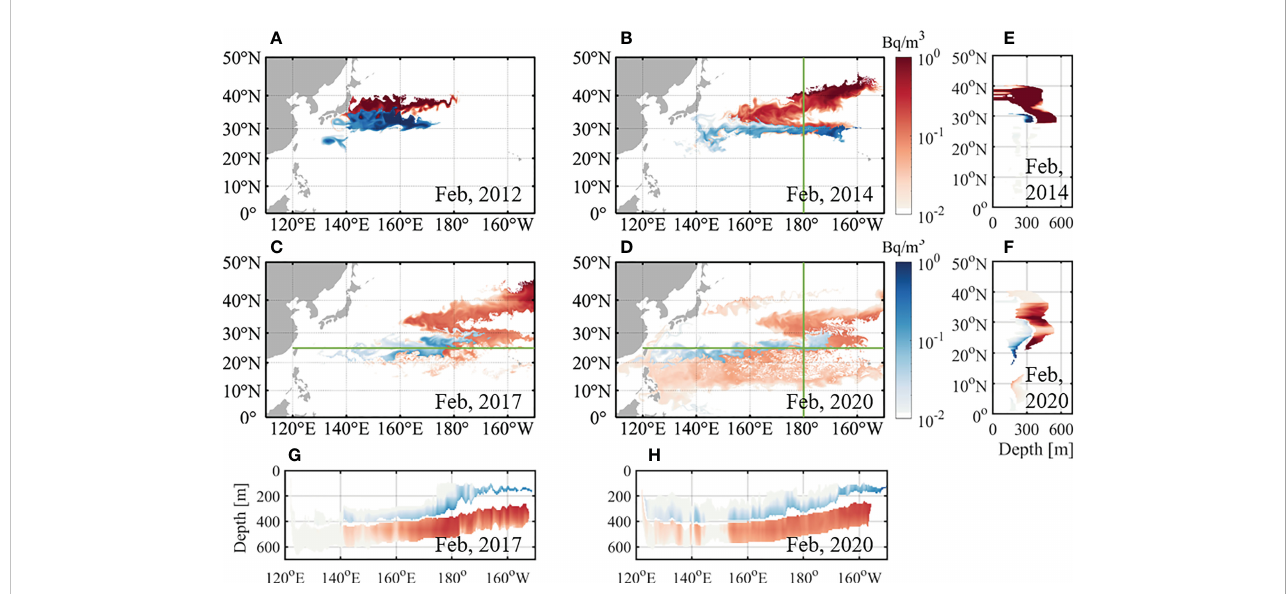
FIGURE 9 Monthly horizontal 137 Cs concentration on the density layer of 25.4 kg/m 3 (blue) and 26.3 kg/m 3 (red) corresponding to STMW and CMW, respectively, in February (A) 2012, (B) 2014, (C) 2017, and (D) 2020. Monthly vertical 137 Cs concentration along the meridional line (green line in (B) and (D) ) at 180° in February (E) 2014 and (F) 2020. Monthly vertical 137 Cs concentration along the zonal line (green line in (C) and (D) ) at 25°N in February (G) 2017 and (H) 2020. 137 Cs concentration was corrected for radioactive decay (30